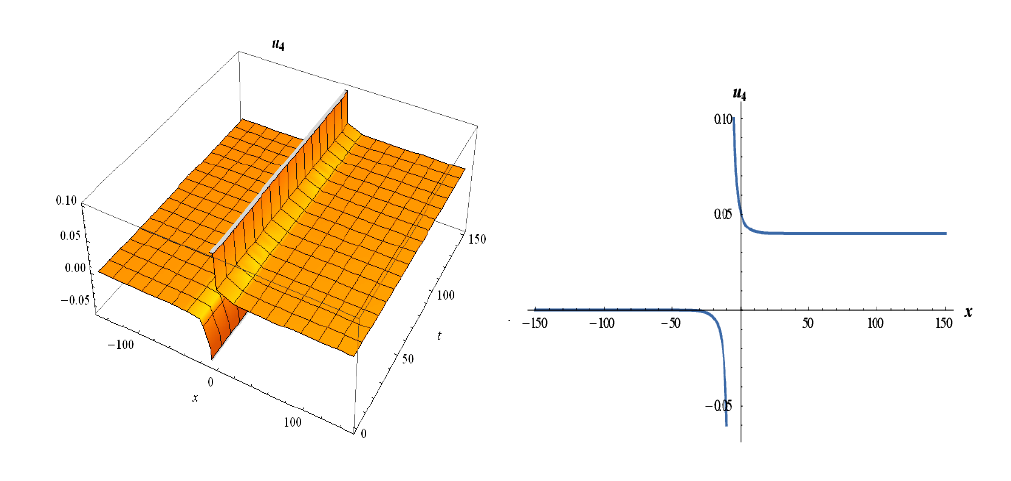
Figure 6. Three and two-dimensional surfaces of (21).